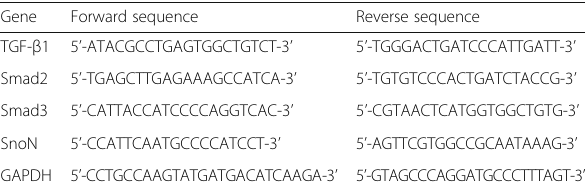
Table 1 PCR primer sequences for TGF- β 1, Smad2, Smad3, SnoN and GAPDH